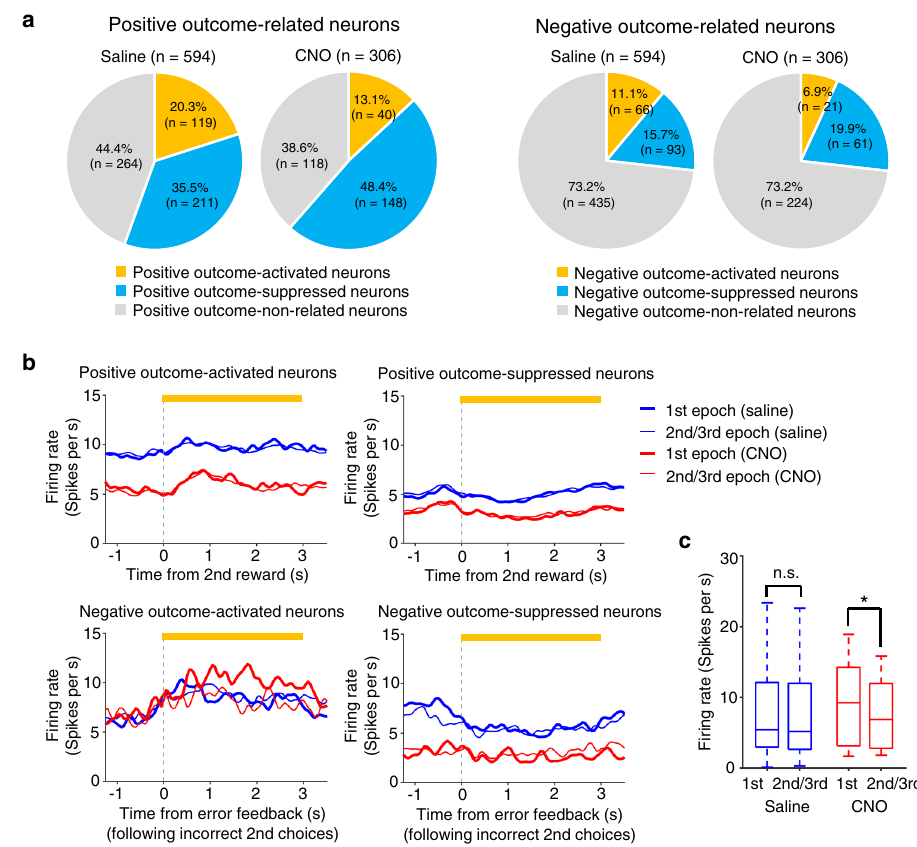
Fig. 7 | Chemogenetic silencing of ACC increased fi ring rate of negative outcome-encoding M2 neurons upon rule switches. a Each M2 neuron ( n =594 neurons and 306 neurons for saline and CNO conditions, respectively) was classi- fi ed based on its activity during the outcome feedback period, i.e., positive outcome-activated neurons, positive outcome-suppressed neurons, negative outcome-activated neurons, and positive negative-suppressed neurons (see Meth- odsfordetails).Theproportionofpositiveoutcome-activatedneuronswassmaller inCNOconditionthaninsalinecondition(13.1%vs20.3%, χ 2 =6.73, P =0.009)while thatofpositiveoutcome-suppressedneuronswasgreaterinCNOconditionthanin salinecondition(48.4%vs35.5%, χ 2 =13.9, P =0.00019).Similarly,theproportionof negative outcome-activated neurons was smaller in CNO condition than in saline condition (6.9% vs 11.1%, χ 2 =4.17, P =0.041) while that of negative outcome- suppressed neurons wassmaller in CNOcondition thaninsaline condition but was not statistically signi fi cant (19.9% vs 15.7%, χ 2 =2.61, P =0.106). b Population-